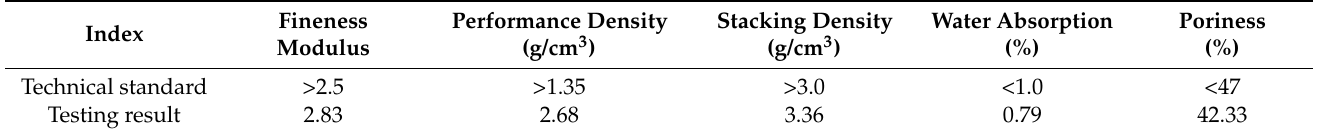
Table 2. Detection indexes of natural sand.